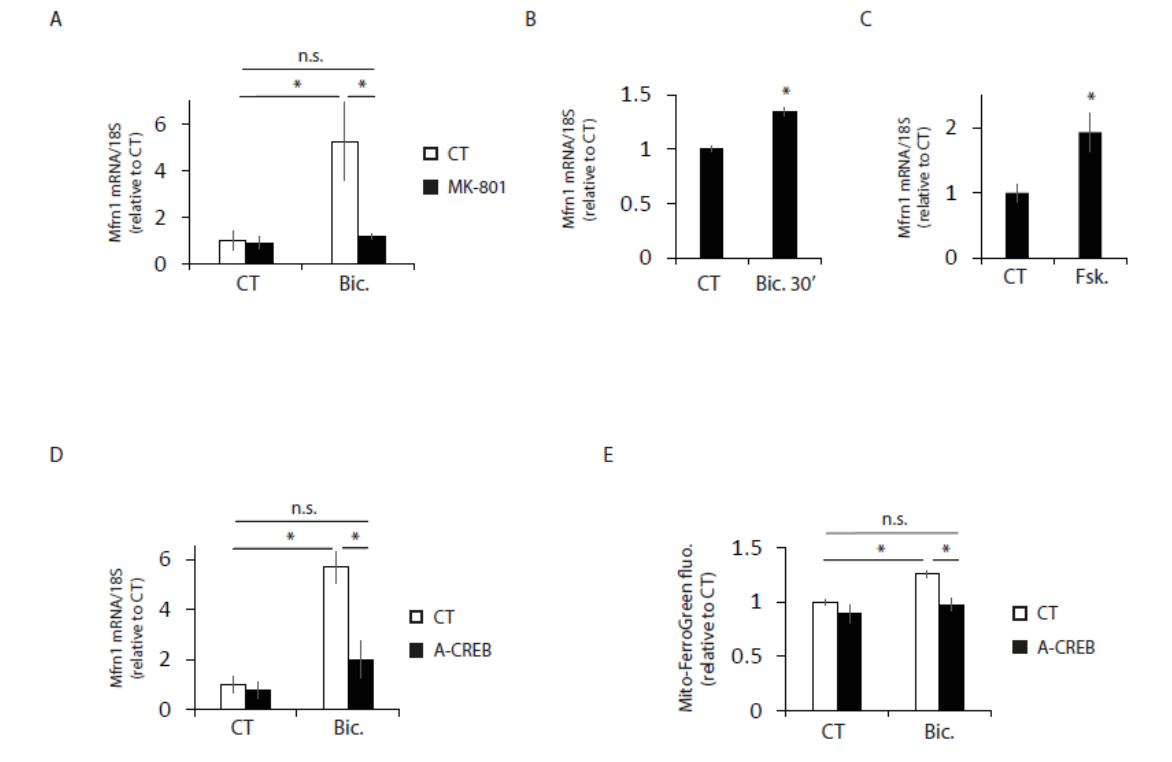
Figure 5. Mfrn1 is regulated by CREB. ( A ) Neurons were stimulated with Bic for 4 h with or without MK-801 (10 µ M), and Mfrn1 mRNA expression was determined by qPCR (n = 5 independent experiments). * p < 0.05, one-way ANOVA, followed by Tukey’s post hoc test. ( B ) Neurons were stimulated for 30 min, and Mfrn1 mRNA expression was determined by qPCR (n = 4 independent experiments). * p < 0.05, two-tailed Student’s t -test. ( C ) Neurons were treated with forskolin (FSK, 10 µ M) for 4 h, and Mfrn1 mRNA expression was determined by qPCR (n = 4 independent experiments). * p < 0.05, two-tailed Student’s t -test. ( D ) Neurons were transduced with AAV encoding the dominant negative A-CREB, and after 4 h stimulation with Bic Mfrn1, mRNA expression was determined by qPCR (n = 3 independent experiments). * p < 0.05, one-way ANOVA, followed by Tukey’s post hoc test. ( E ) Analysis of Mito-FerroGreen fluorescence intensity in CT and AAV-CREB transduced neurons left unstimulated or stimulated with Bic for 24 h. (n = 3 independent experiments). * p < 0.05, one-way ANOVA, fol lowed by Tukey’s post hoc test. n.s. = non-significant.